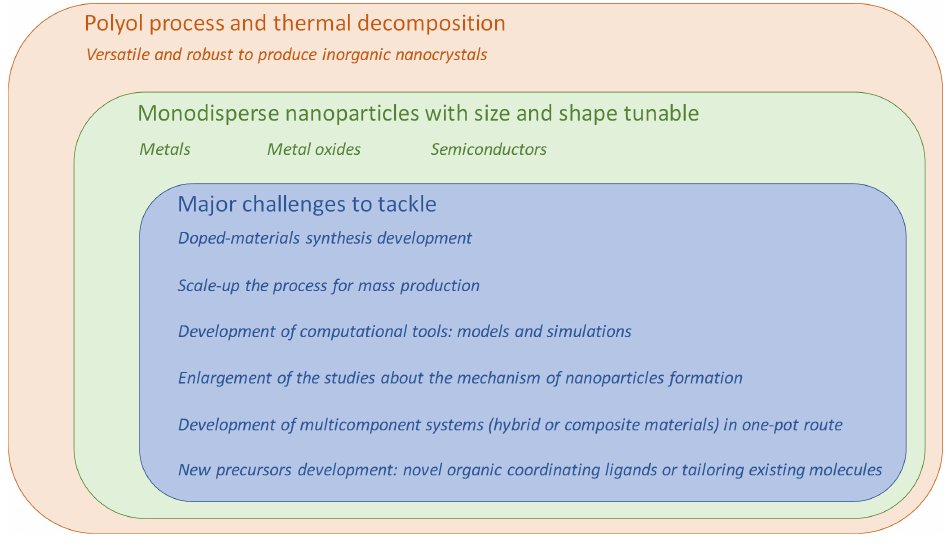
Figure 7 - The major features and challenges of the methodologies based on the polyol process and thermal